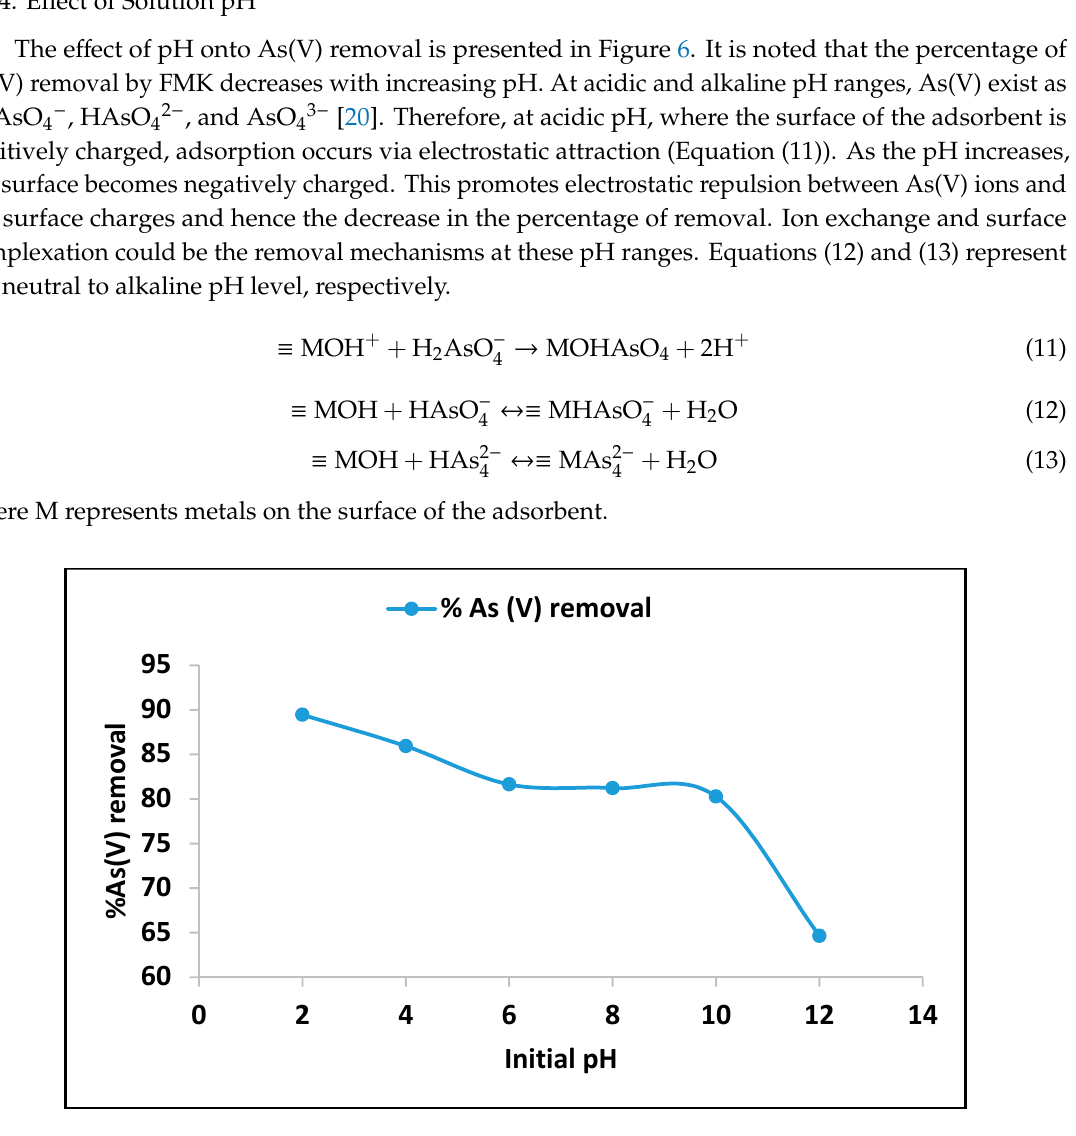
Figure 6. The effect of initial pH on As(V) removal onto FMK (Initial As(V) concentration 5 mg/L, 0.4 Figure 6. The e ff ect of initial pH on As(V) removal onto FMK (Initial As(V) concentration 5 mg / L, g/100 mL adsorbent dosage, 60 min contact time at 250 rpm shaking speed). 0.4 g / 100 mL adsorbent dosage, 60 min contact time at 250 rpm shaking